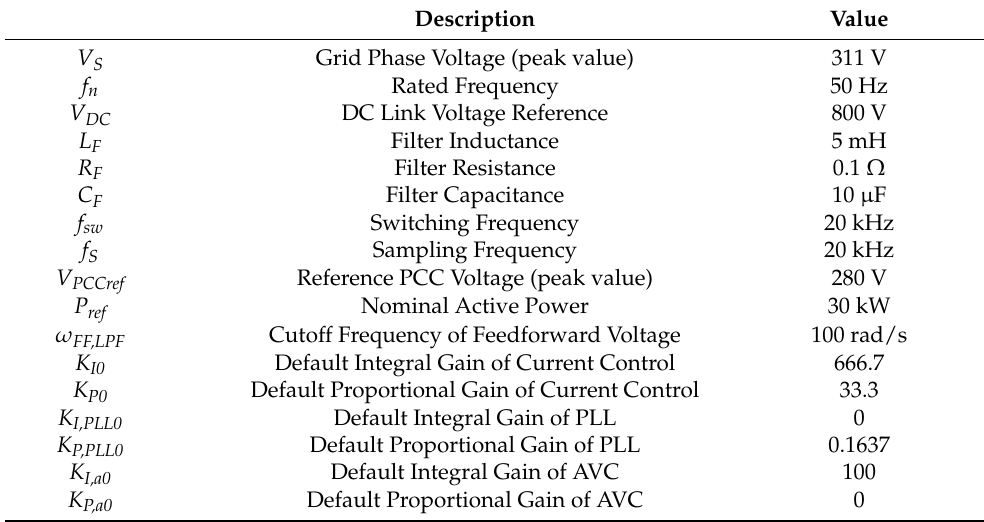
Table A1. System and default control